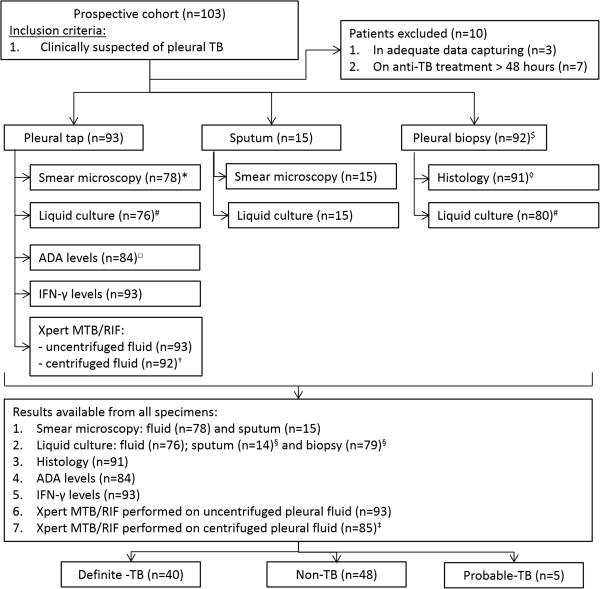
Patient flow and test results available for final diagnoses. $biopsy not performed (n = 1); *no fluid smear requested (n = 15); #liquid culture not requested, pleural fluid (n = 17) and pleural biopsy (n = 12); §indeterminate liquid culture: contamination (n = 1) and sample rejected (n = 1); ◊histology not requested (n = 1); □ADA measurements not requested (n = 9); †sample lost during processing (n = 1), ‡indeterminate Xpert MTB/RIFF result (n = 7).